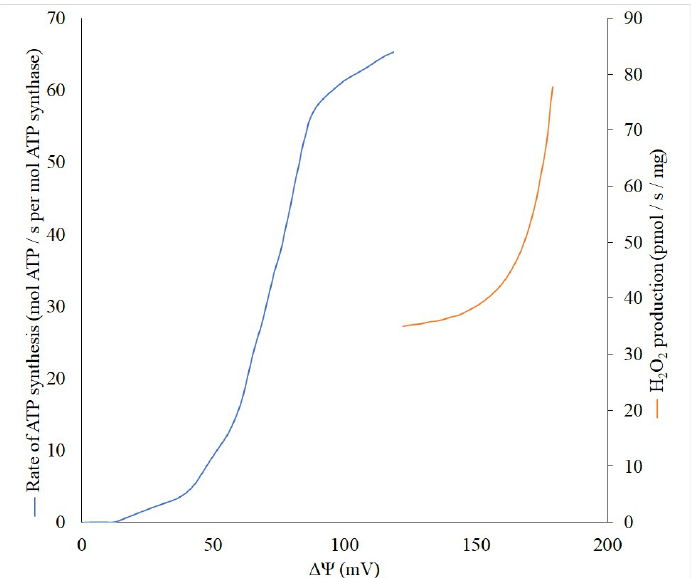
Figure 1. Dependence of the generation of ROS (red) and ATP (blue) on the values of the mem- brane potential ( ∆Ψ ). ROS generation was measured on isolated rat brain mitochondria with α -ketoglutarate as a substrate (from [30], with modifications). Differences in membrane potential were generated by adding various concentrations of FCCP ranging from 0 to 80 nM. ATP generated was measured using reconstituted E.coli ATP synthase. K + /valinomycin diffusion potentials were applied in the presence of ΔpH (from [34] with modifications) .